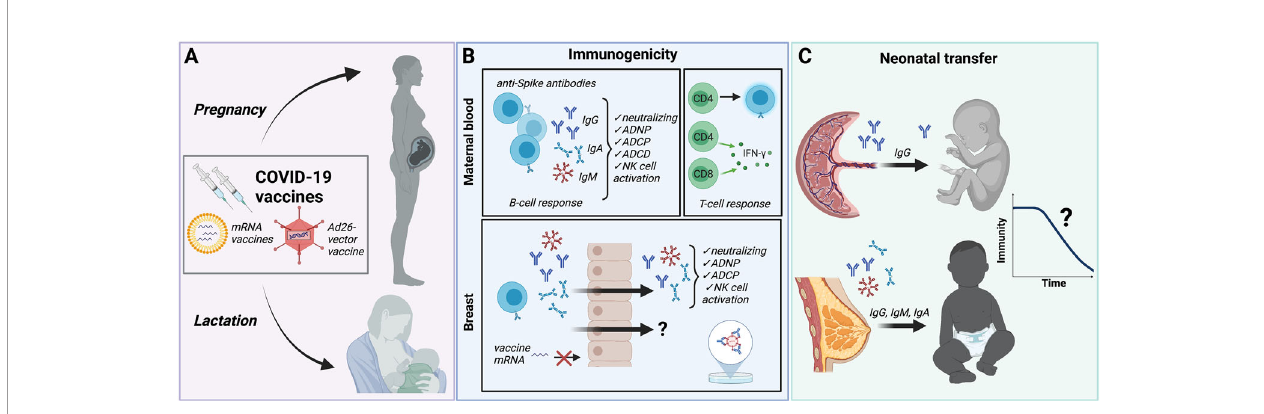
FIGURE 1 | Summary of immune protection from COVID-19 vaccines in pregnancy and lactation. (A) Although excluded from initial vaccine trials, pregnant and lactating individuals have been eligible to receive P fi zer/BioNTech and Moderna mRNA vaccines and the Janssen/Johnson&Johnson Ad26-vector vaccine. Safety and reactogenicity pro fi les are similar to non-pregnant, non-lactating individuals. Immunization with the two-dose protocol for mRNA vaccines results in comparable IgG, IgA and IgM titers in fully-vaccinated pregnant and lactating individuals compared to non-pregnant controls. The longevity of immunity derived during pregnancy and the ability to confer protection against variants has not been directly studied in these populations. (B) COVID-19 vaccines generate anti-Spike antibodies in pregnant and lactating individuals with similar immunogenicity compared with non-pregnant controls. Vaccine-induced anti-Spike antibodies demonstrate neutralizing capacity, antibody-dependent neutrophil phagocytosis (ADNP), antibody-dependent cellular phagocytosis (ADCP), and antibody-dependent complement deposition (ADCD), and NK cell activation. Spike-speci fi c CD4+ and CD8+ T-cell activity is similar to that observed in non-pregnant individuals. Anti-Spike IgG and IgA with binding, neutralizing and functional activity are also detectable in breastmilk. Whether breastmilk contains vaccine-induced cellular or other protective immune factors is not yet known. No vaccine mRNA has been detected in breastmilk immediately following vaccination. (C) Neutralizing anti-Spike IgG is transplacentally transferred from mother to fetus. Vaccine timing and maternal antibody titers impact cord titers. IgG, IgM and IgA are transferred through breastmilk. Neither the amount of maternally-derived antibodies required to confer neonatal protection from COVID-19 infection, nor the duration of this protection, is known. Created with BioRender.com. ADNP, antibody-dependent neutrophil phagocytosis; ADCP, antibody-dependent cellular phagocytosis; ADCD, antibody-dependent complement